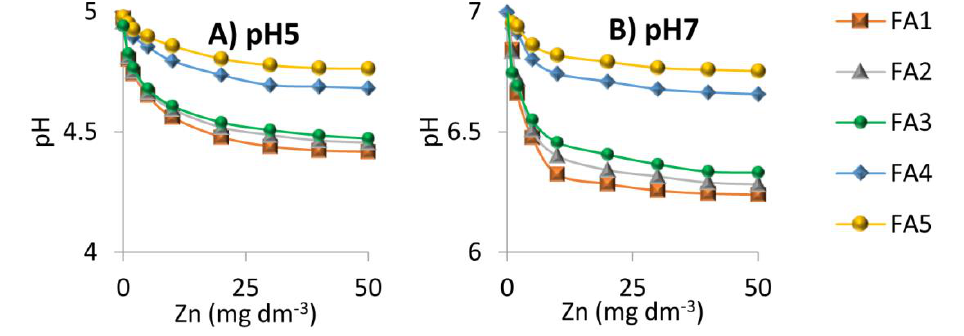
Figure 7. The pH drop of the FAs solutions during interactions with increasing Zn(II) concentration for the systems at ( A ) pH 5; ( B ) pH 7.